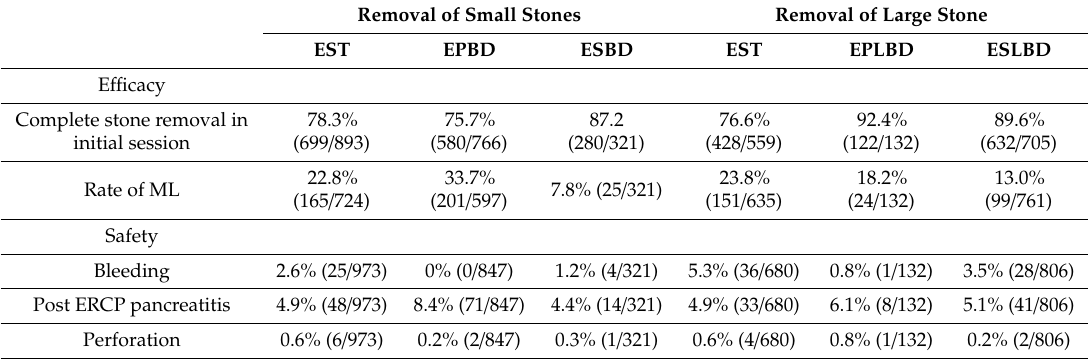
Table 4. Comparison of the procedures on the papilla. Rate of each procedure based on the results of the analysis (Figures 1–3).